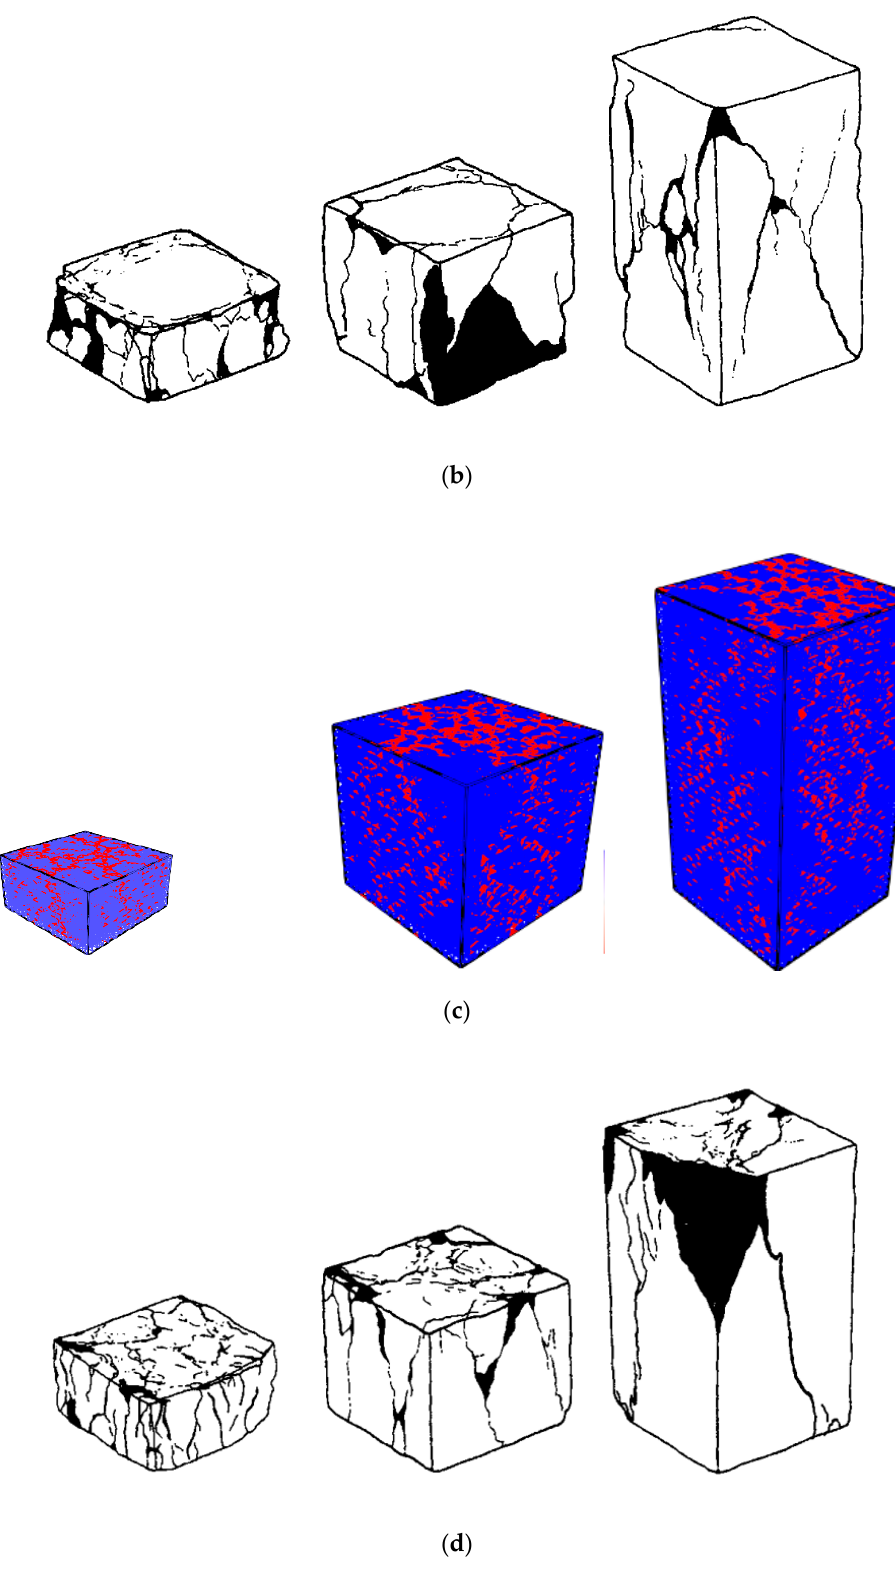
Figure 5. Crack patterns for ( a ) high friction boundary condition in numerical analysis, ( b ) high friction boundary condition from the literature [51]. Reproduced from [51]. Copyright 1996, Wiley Online Library. ( c ) low friction boundary condition in numerical analysis, ( d ) low friction boundary condition from the literature [51] (red-cracked element). Reproduced from [51]. Copyright 1996, Wiley Online Library.